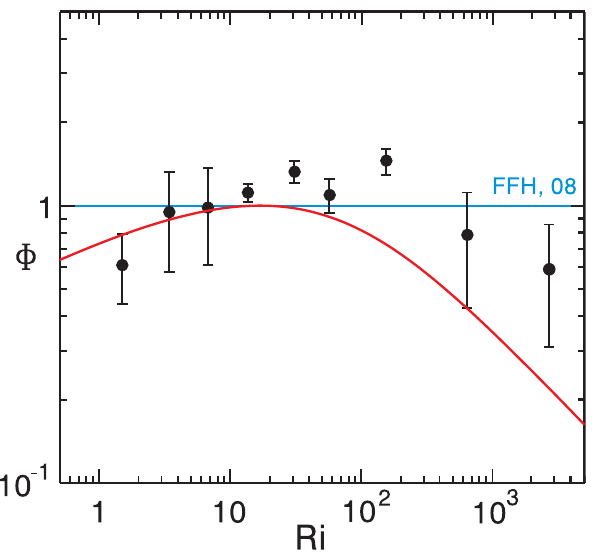
Fig. 4. Richardson number dependence of the two ratios in Eq. (15a, d). The first ratio, represented by full circles with error bars, correspond to updated results from Fox-Kemper’ Comments to our manuscript during the Discussion phase: Ocean. Sci. Dis- cuss. 6, C916–C926, 2009, http://www.ocean-sci-discuss.net/6/. The results of the present model given by Eq.(15e) with C =6 are shown by the full line. The blue line corresponds to the FFH pa- rameterization, 8 =1.